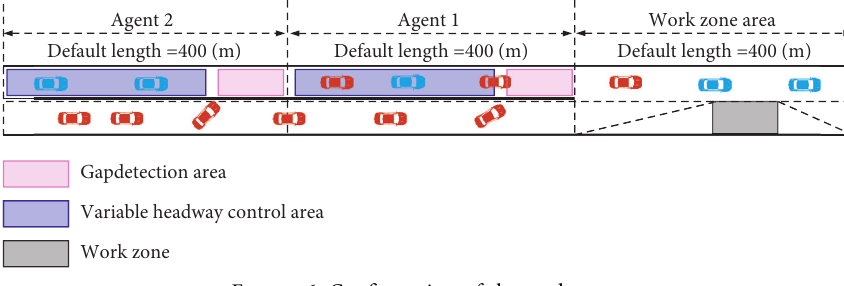
Figure 6: Configuration of the study